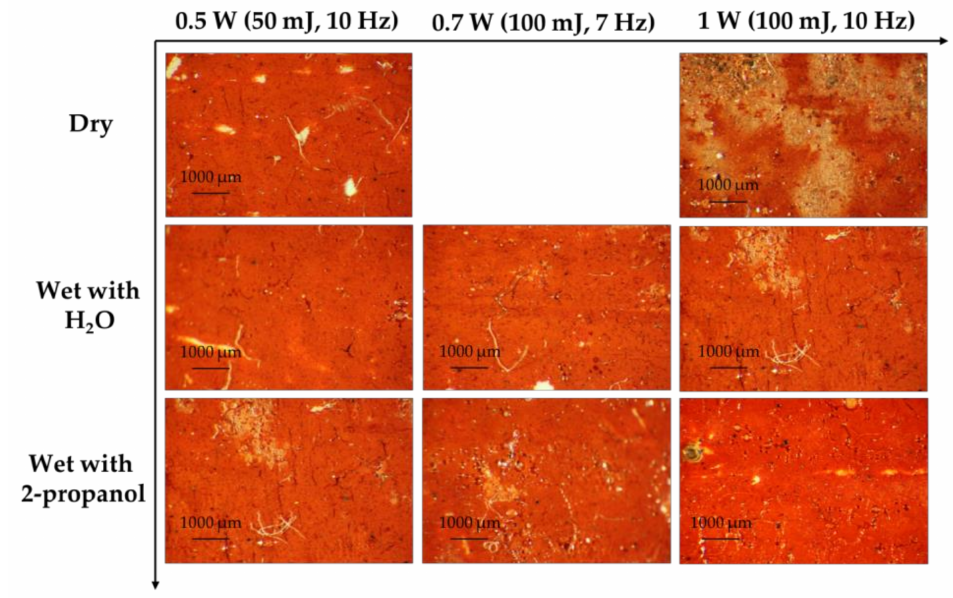
Figure 13. The microscopic images (32 × ) of the eight sections of P B67 varnished cinnabar tempera mock-ups after different laser cleaning conditions and